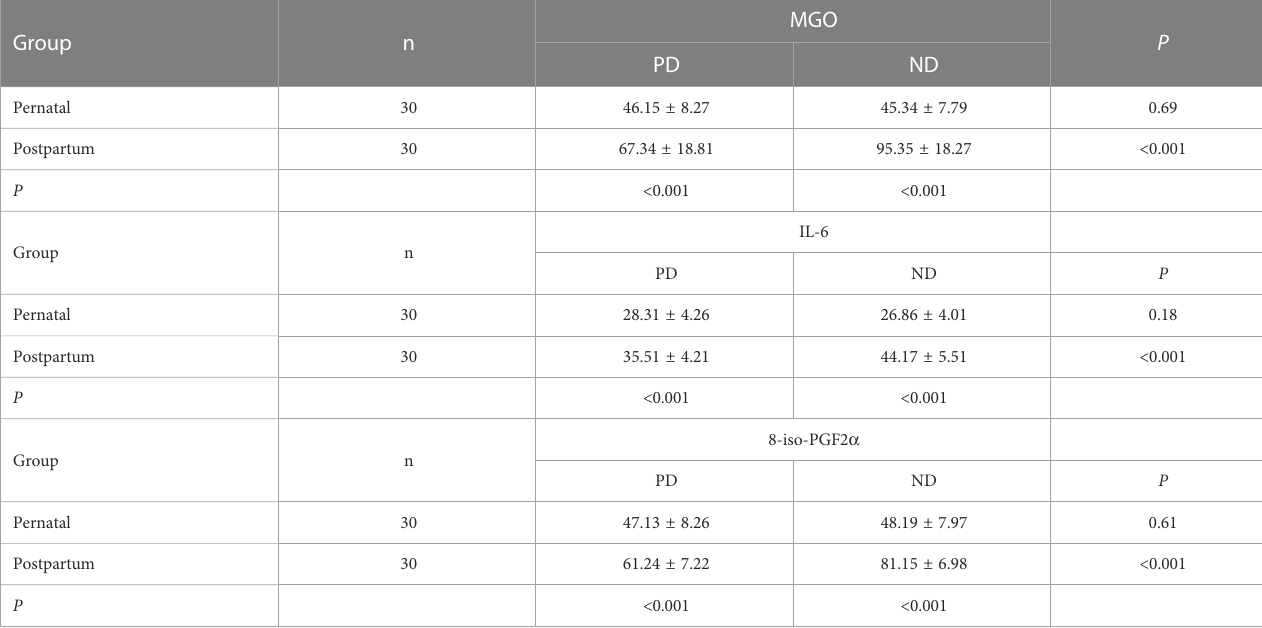
TABLE 2 Comparison of prenatal and postpartum serum MGO, IL-6, and 8-iso-PGF2 a levels between the PD and ND groups.